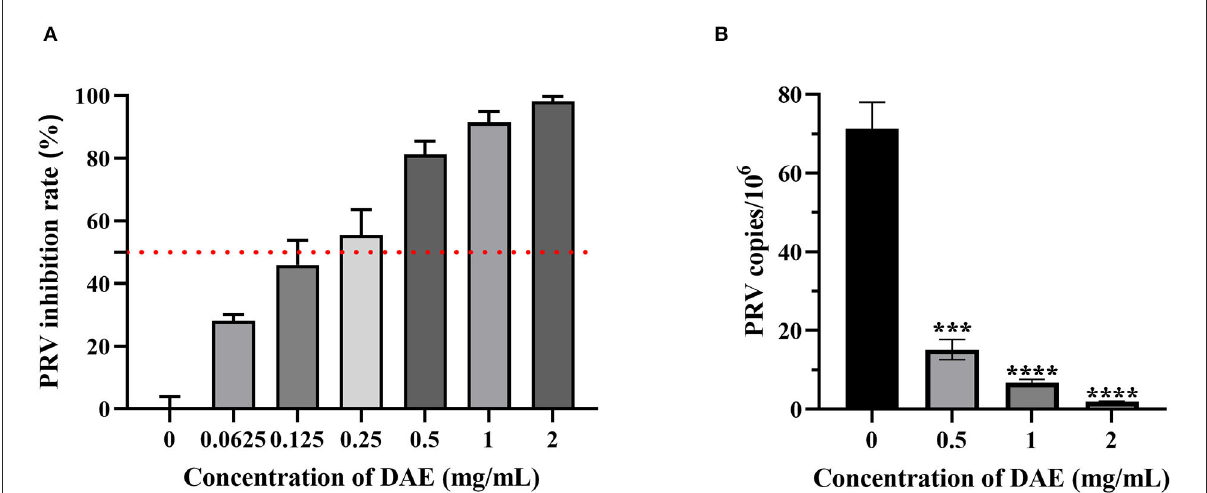
FIGURE2 Antiviral effect of DAE on PRV in PK15 cells. (A) The inhibitory effect of DAE on PRV in PK15 cells. PRV (100 TCID 50 ) was mixed with an equal volume of DAE (0.0625–2 mg/mL) at 37 ◦ C for 1h, and the mixture was overlaid on PK15 cells for 1h before replacement with 2% DMEM. After incubation for 48h, CCK8 assays were performed, and the results are expressed as the percent inhibition of the drug-treated group compared with the untreated group. (B) PRV copies in infected cells were quantified by FQ-PCR (**** P < 0.0001, *** P <